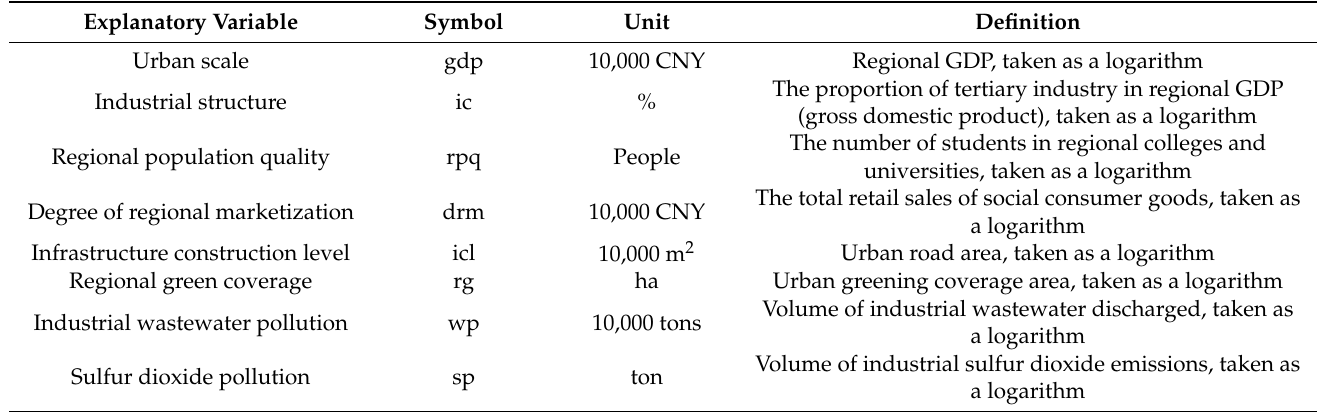
Table 3. Description of explanatory variables of the Tobit regression model.